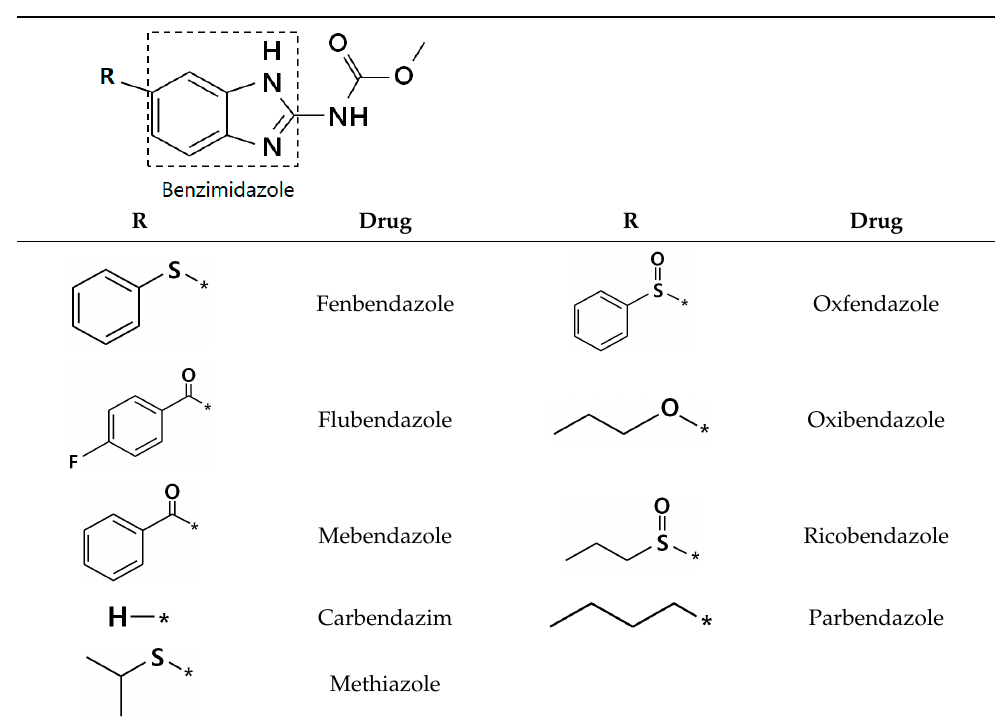
Table 1. Chemical Structures of Benzimidazoles.